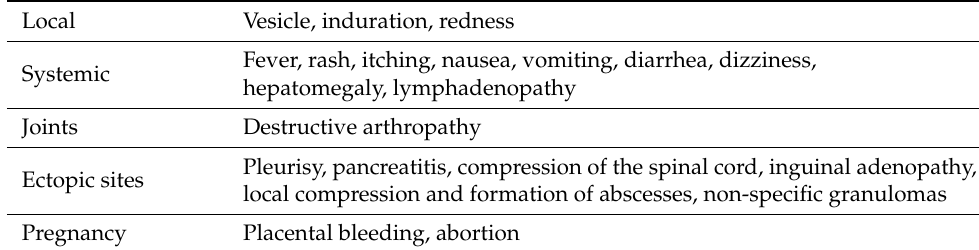
Table 2. Clinical manifestations of